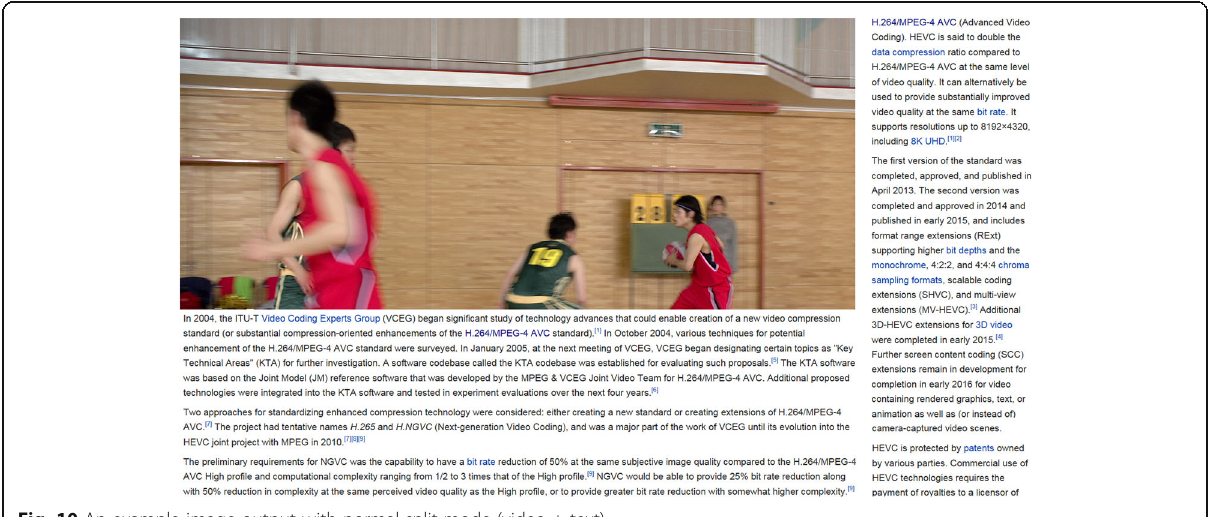
Fig. 10 An example image output with normal split mode (video +